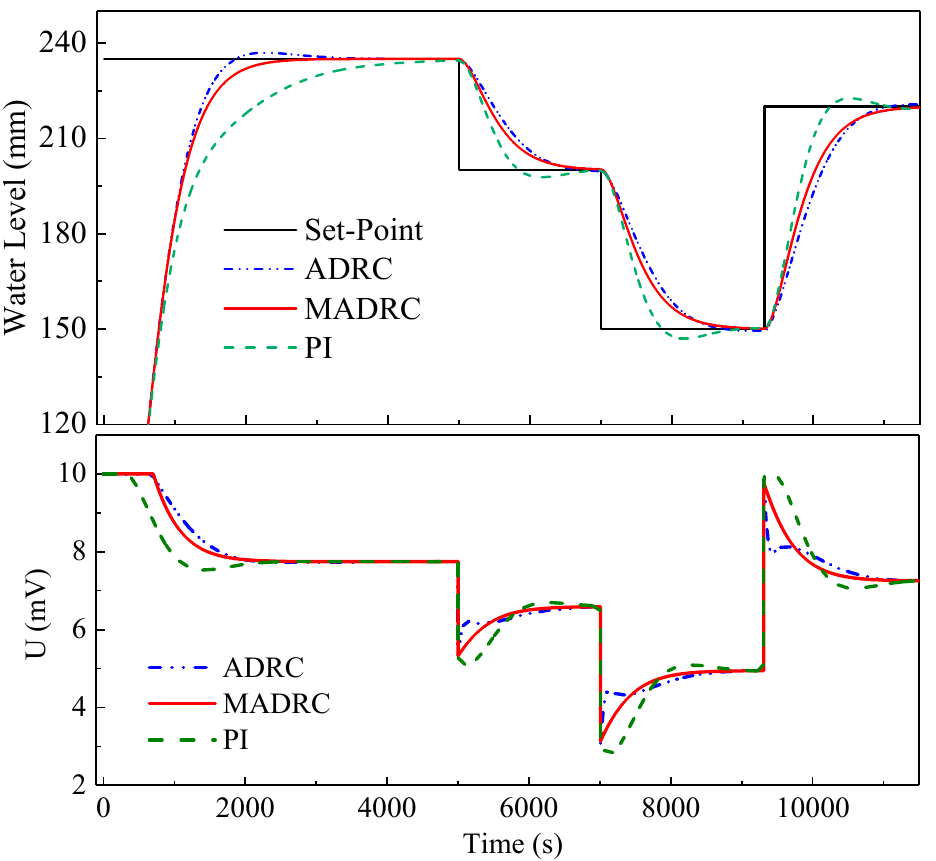
Figure 9. Simulation of reference tracking. Steps occur at 0 s, 5003 s, 7009 s, and 9310 s .